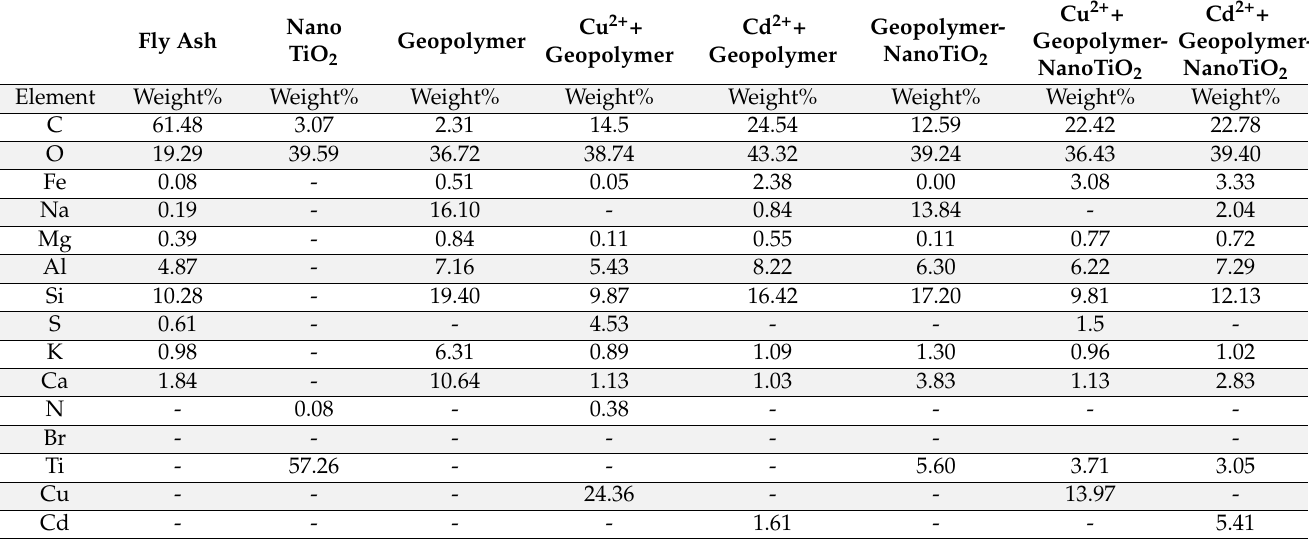
Table 4. Results of EDS characterization of fly ash, NanoTiO 2 , adsorbents geopolymer and geopolymer- NanoTiO 2 before and after